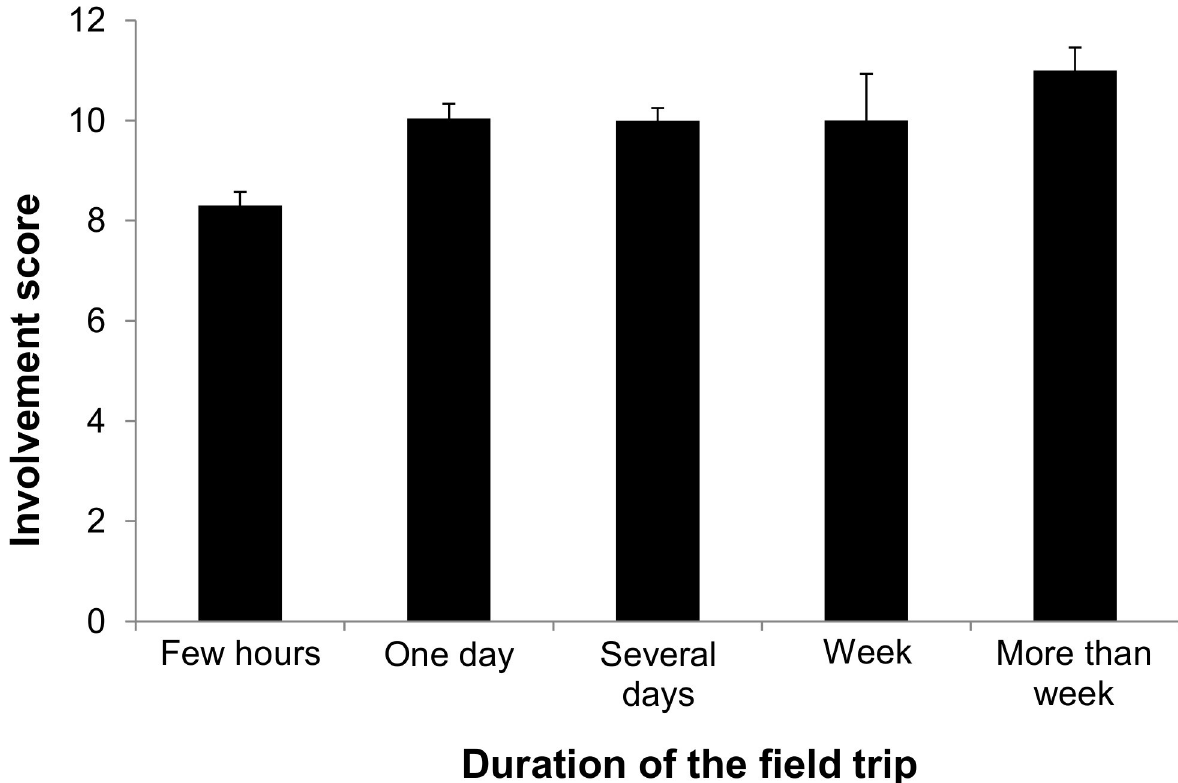
Fig 3. Mean involvement scores of birdwatchers in relation to duration of the field trips in which they participated.